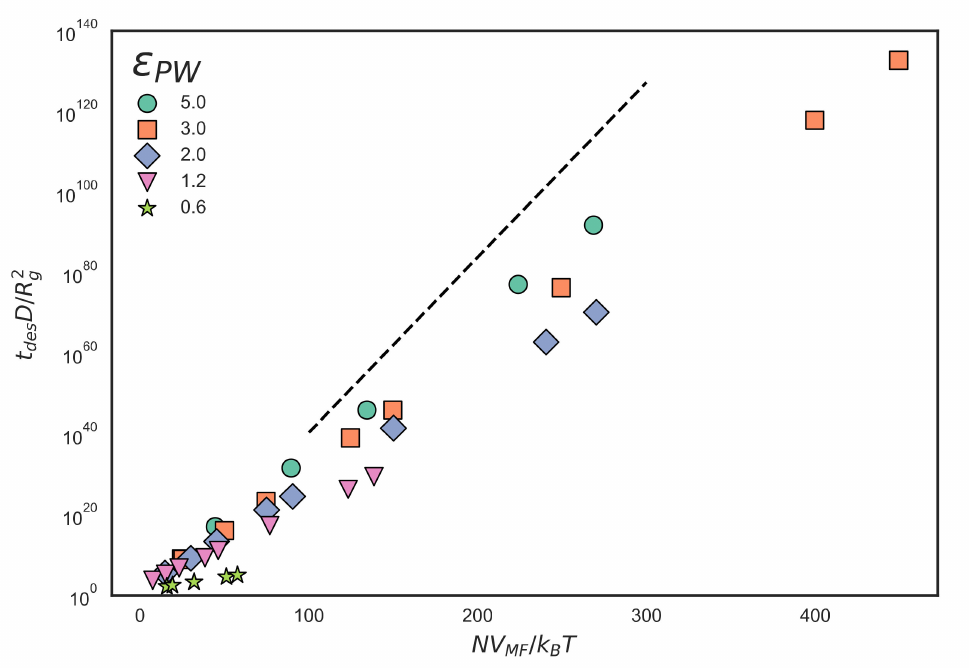
Figure 7. Desorption times calculated from FFS for freely-jointed chains with excluded volume (FJC + EV) polymers using several values of ε PW in units of kJ / mol and plotted against NV MF V MF is the mean-field potential defined in Equation (1). The dashed line represents t des D where A is an arbitrary constant selected for visual clarity and R g is the radius of gyration. Error bars are omitted because they are smaller than the marker size in almost all cases, because of the enormity of scale of the